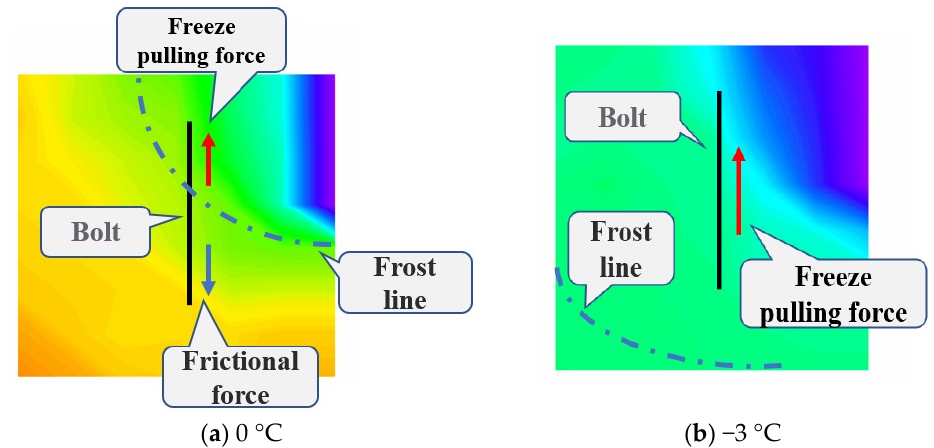
Figure 14. Schematic diagram of the bolt force under different temperature gradients.